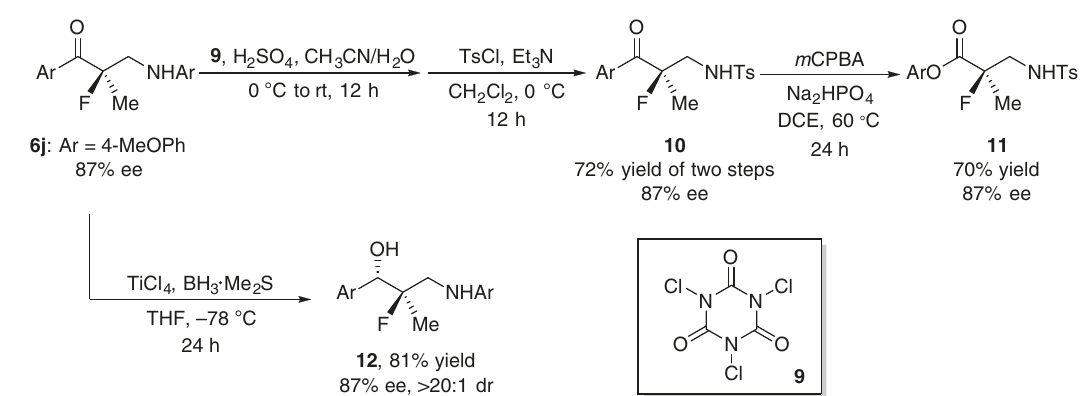
Fig. 5 Synthetic utilities. The synthesis of β 2 - fl uoro- β 2 -substituted amino ester 11 and fl uorohydrin 12 from chiral β - fl uoro- β -methyl amino ketone 6j